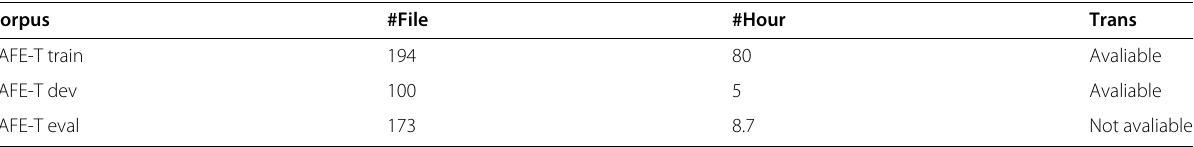
Table 1 OpenSAT20 data partition statistics Corpus #File SAFE-T